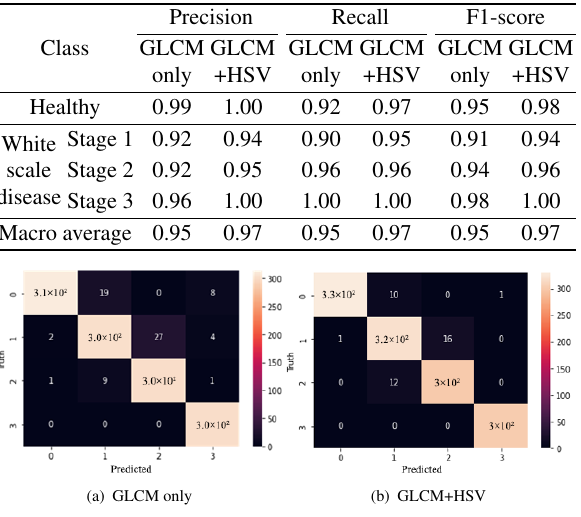
Fig. 8 Confusion matrices of RF